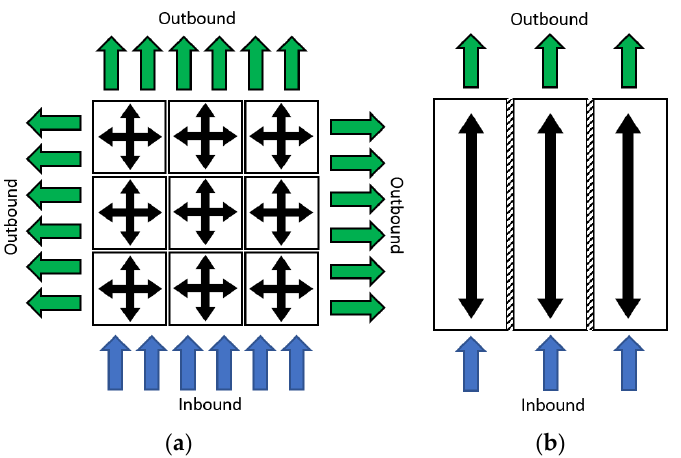
Figure 2. Comparison of two types of carton carriers: ( a ) omni or multidirectional cellular conveyor allows multiple inbounds and outbounds for different sizes of carton, whereas ( b ) roller or belt conveyor has lesser inbounds and outbounds and carton must not be bigger than the width of conveyor line.